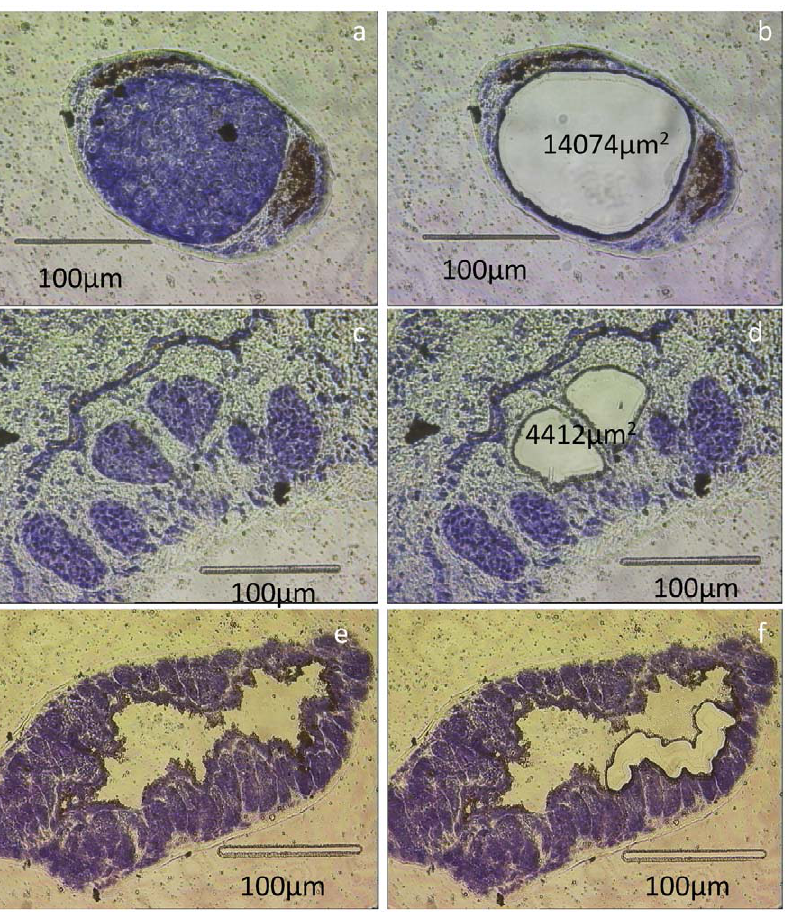
Figure 1. Laser Microdissection of adult S.mansoni . Sections of male and female S. mansoni , before and after microdissection, stained with 1% (w/v) toluidine blue. The left column shows the ovary (a), testes (c) and gastrodermis (e) before microdissection, while the right column shows the same sections of the ovary (b), testes (d) and gastrodermis (f) after microdissection.